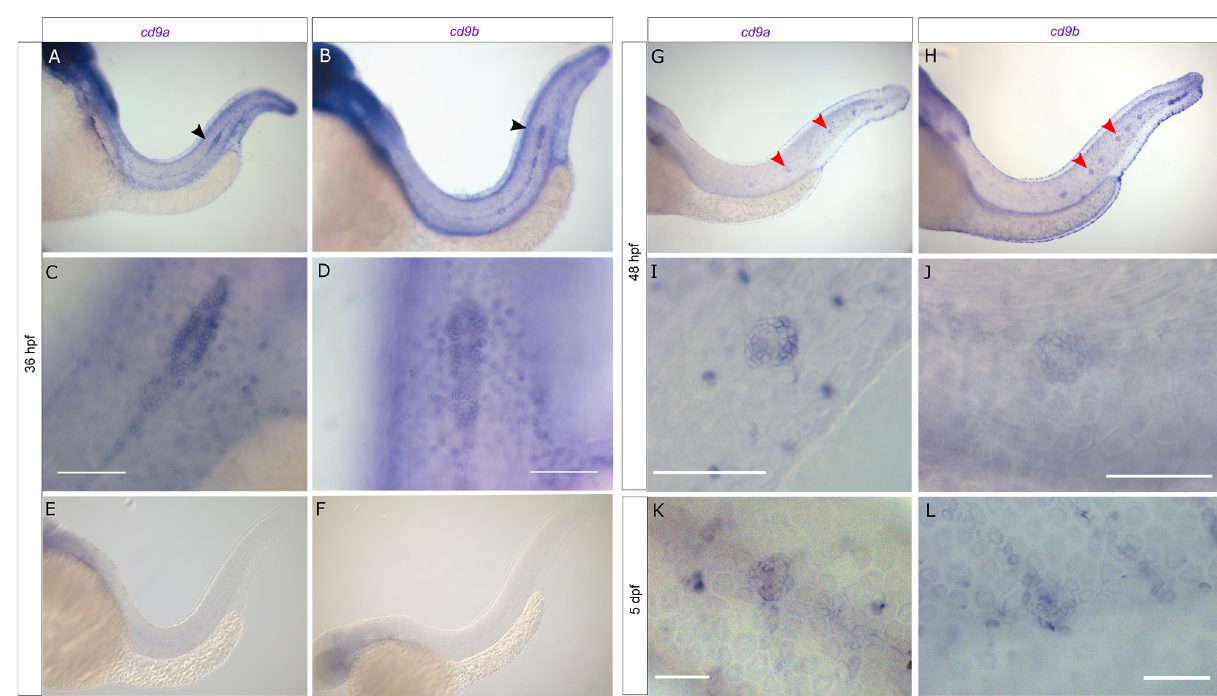
Fig 1. cd9a and cd9b are expressed in the pLLP during zebrafish development. A-F: Micrographs of WISH of cd9a and cd9b at 36 hpf with sense and anti-sense probes. (a-b) Overview shows staining in pLL; (c-d) higher resolution images show expression in the primordium; (e-f) sense probes show no staining. G-J: WISH of cd9a and cd9b at 48 hpf; (g-h) overview shows staining in pLL; (i-j) higher resolution images show expression in a neuromast. K-L: WISH of cd9a and cd9b at 5 dpf in a neuromast. Arrows indicate primordium (black) and neuromasts (red). Scale bar indicates 50 μ m (white).